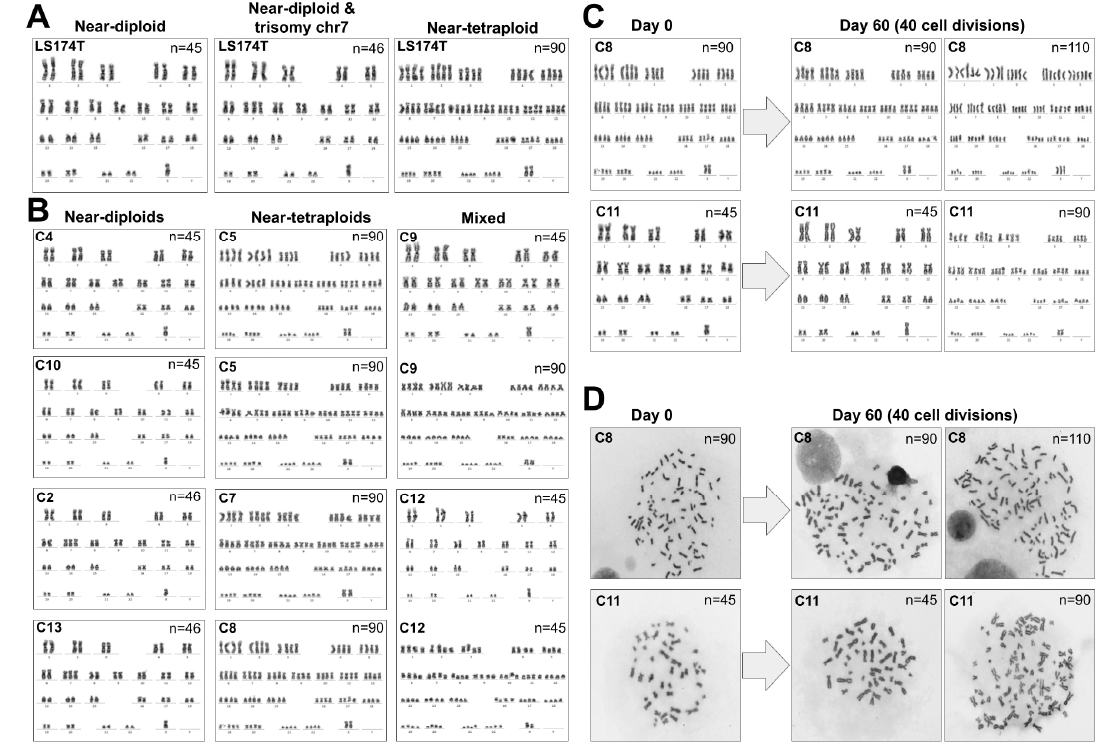
Figure 2. ( A ) Karyotypes of the parental cell line LS174T exhibited a mixture of near-diploid (n = 45, left), near-diploid with trisomy of chromosome 7 (n = 46, middle) and near-tetraploid cells (n = 90, right). ( B ) Left, karyotypes of near-diploid clones C4 and C10 (n = 45) and near-diploid clones C2 and C13 with trisomy of chr7 (n = 46); middle, near-tetraploid clones C5, C6, C7 and C8; right, clones with mixture of karyotypes C9 and C12. ( C ) Karyotypes of LS174T clones C8 and C11. At time 0 (left), C8 cells were pure near-tetraploids, and C11 cells were almost pure near-diploids. After 60 days of culture (right), C8 cells remained mostly near-tetraploid with the occasional appearance of higher ploidy cells, while C11 cells exhibited 13.3% of near-tetraploid cells. ( D ) Metaphases of the karyotypes presented in panel C.